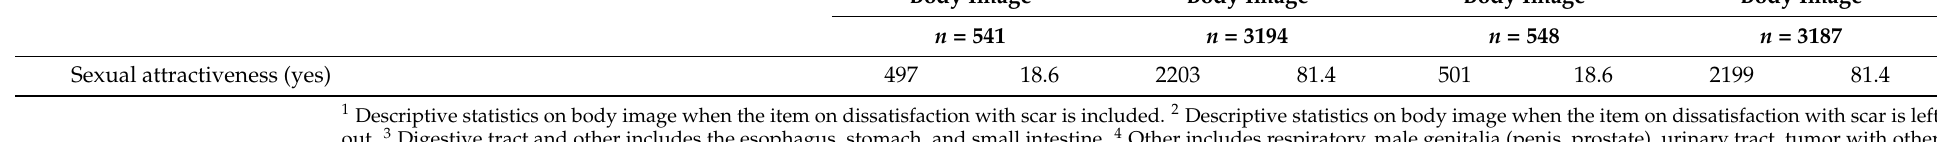
Population Characteristics